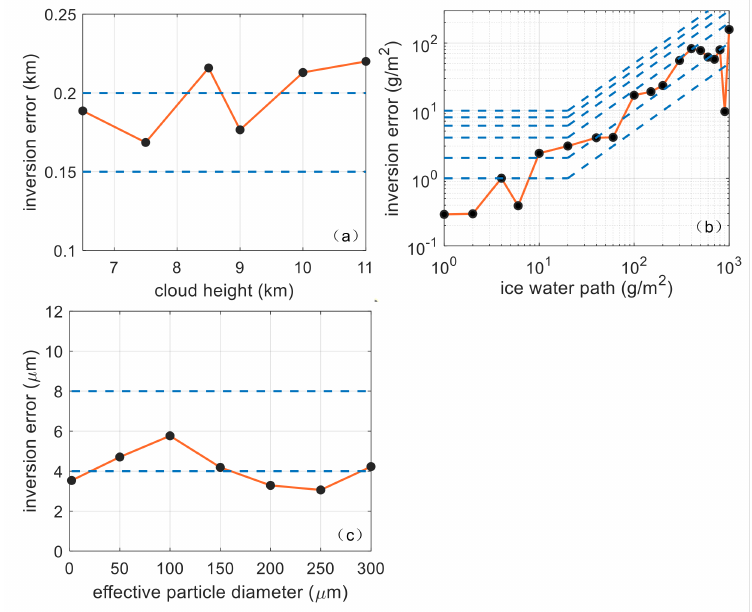
Figure 6. Inversion error for the different ice cloud parameters: ( a ) median absolute errors at different cloud heights, ( b ) median errors at different ice water paths, and ( c ) median absolute errors at different effective particle